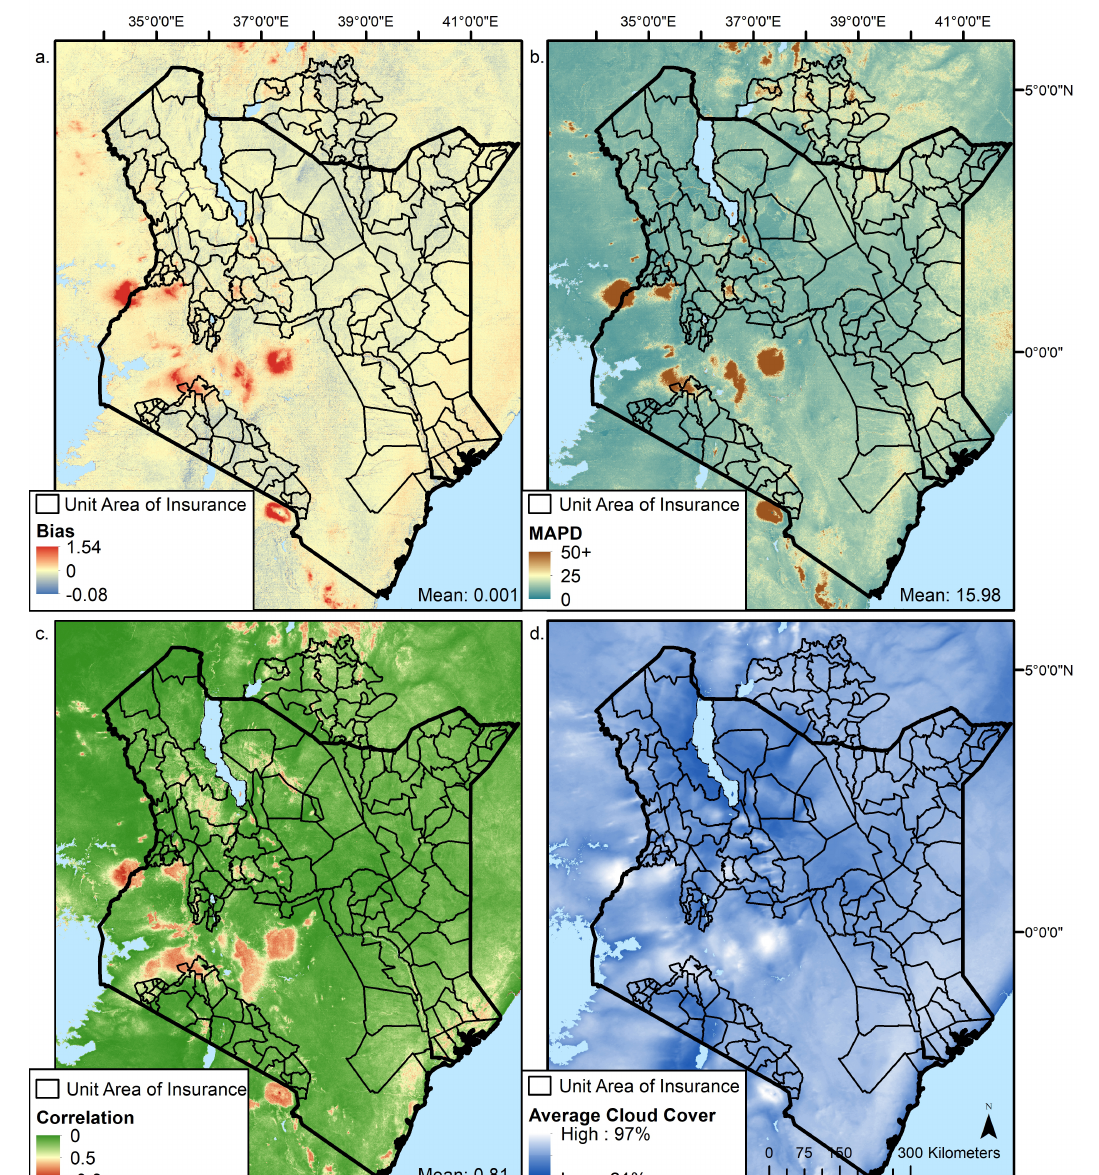
Figure 3. Bias ( a ), mean absolute percent difference ( b ), and correlation between reNDVI and Famine Early Warning Systems Network (FEWS NET) eMODIS NDVI ( c ) for 2003–2019 compared to average cloud cover ( d